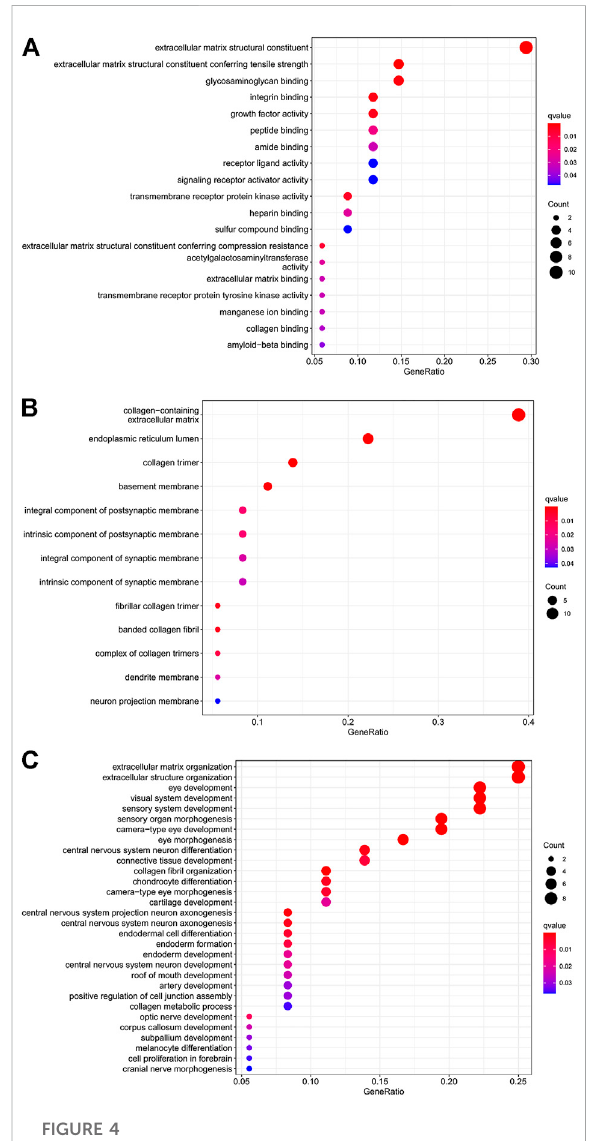
FIGURE 4 Dot plot of GO function enrichment analysis. (A) Molecular function analysis. (B) Cellular component analysis. (C) Biological process